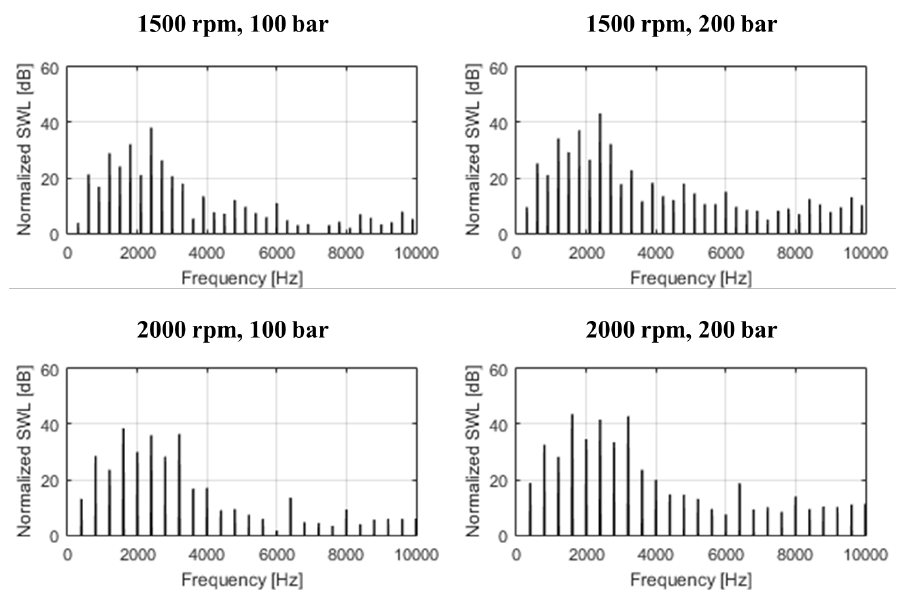
Figure 19. Normalized sound power level spectra for the four operating conditions.